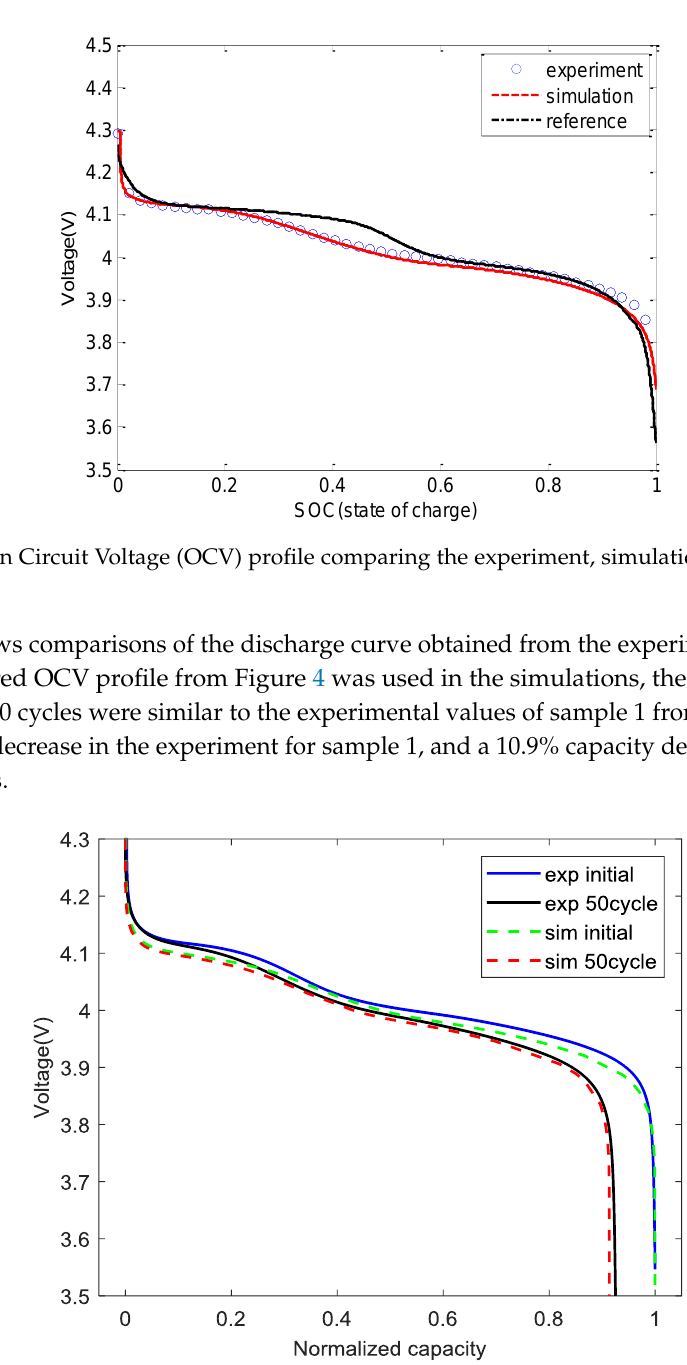
Figure 5. Comparison of discharge curves from experiments and simulations for sample 1.